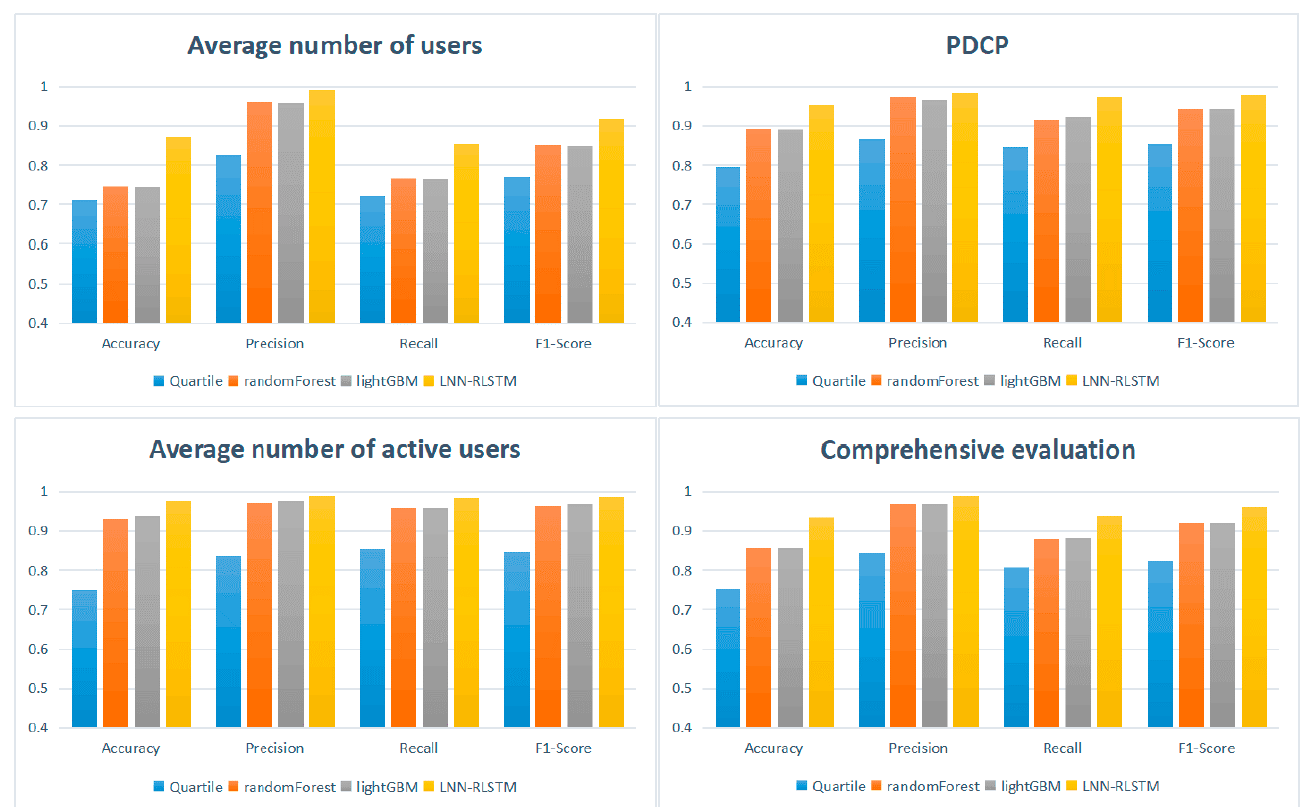
Figure 13. Performance based on four metrics under different models with three KPIs.